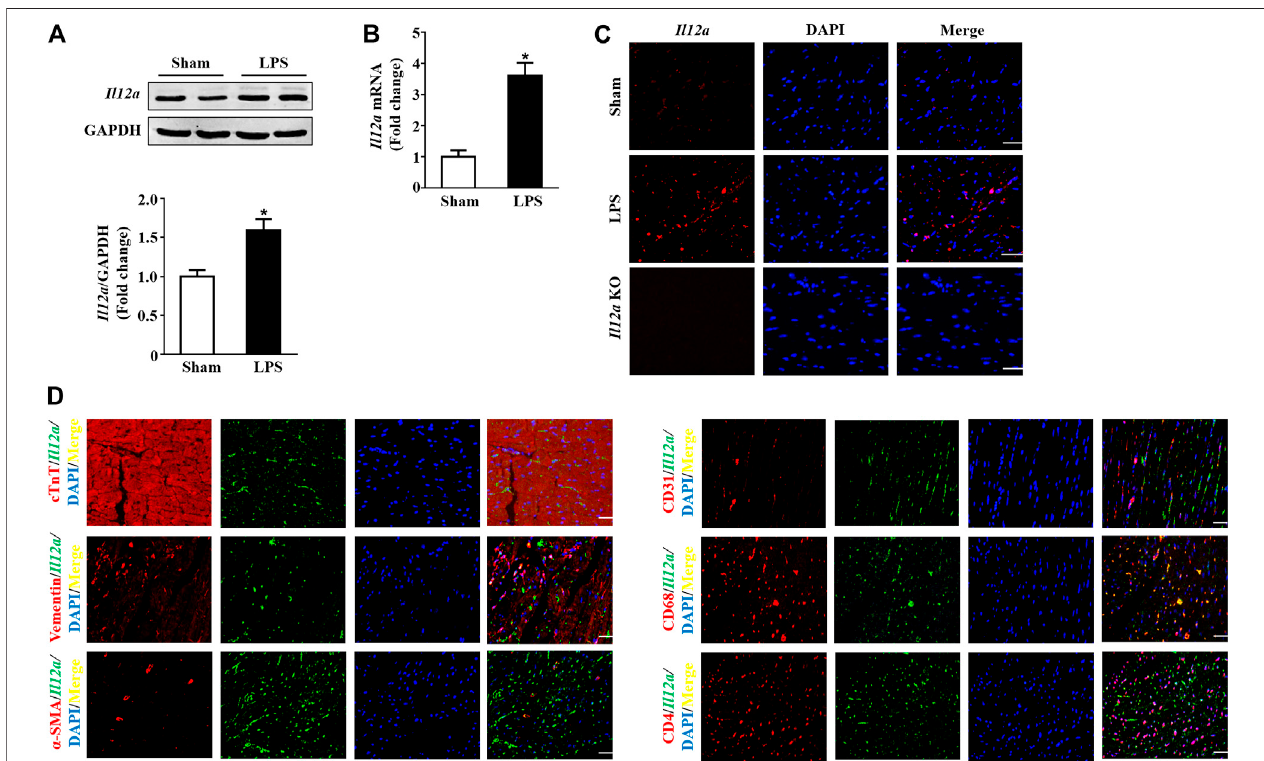
FIGURE1| Il12a expressionisupregulatedinmiceafterLPStreatment. (A,B) WesternblotandRT-PCRanalysisof Il12a proteinandmRNAexpressionlevelsinthe hearts of each group (n (cid:1) 4). (C) Immuno fl uorescence staining for Il12a in the hearts of each group (n (cid:1) 4; scale bar, 50 μ m). (D) The source of Il12a in the heart of mice after LPS treatment was detected by double immuno fl uorescence staining (n (cid:1) 4; scale bar, 50 μ m). * p < 0.05 compared with the sham group.